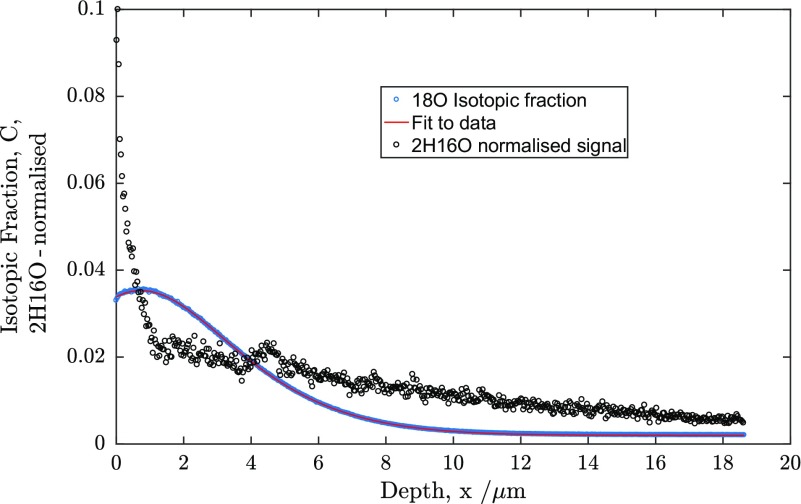
Comparison of the 2H16O− signal with the isotopic exchange profile for sample 2.